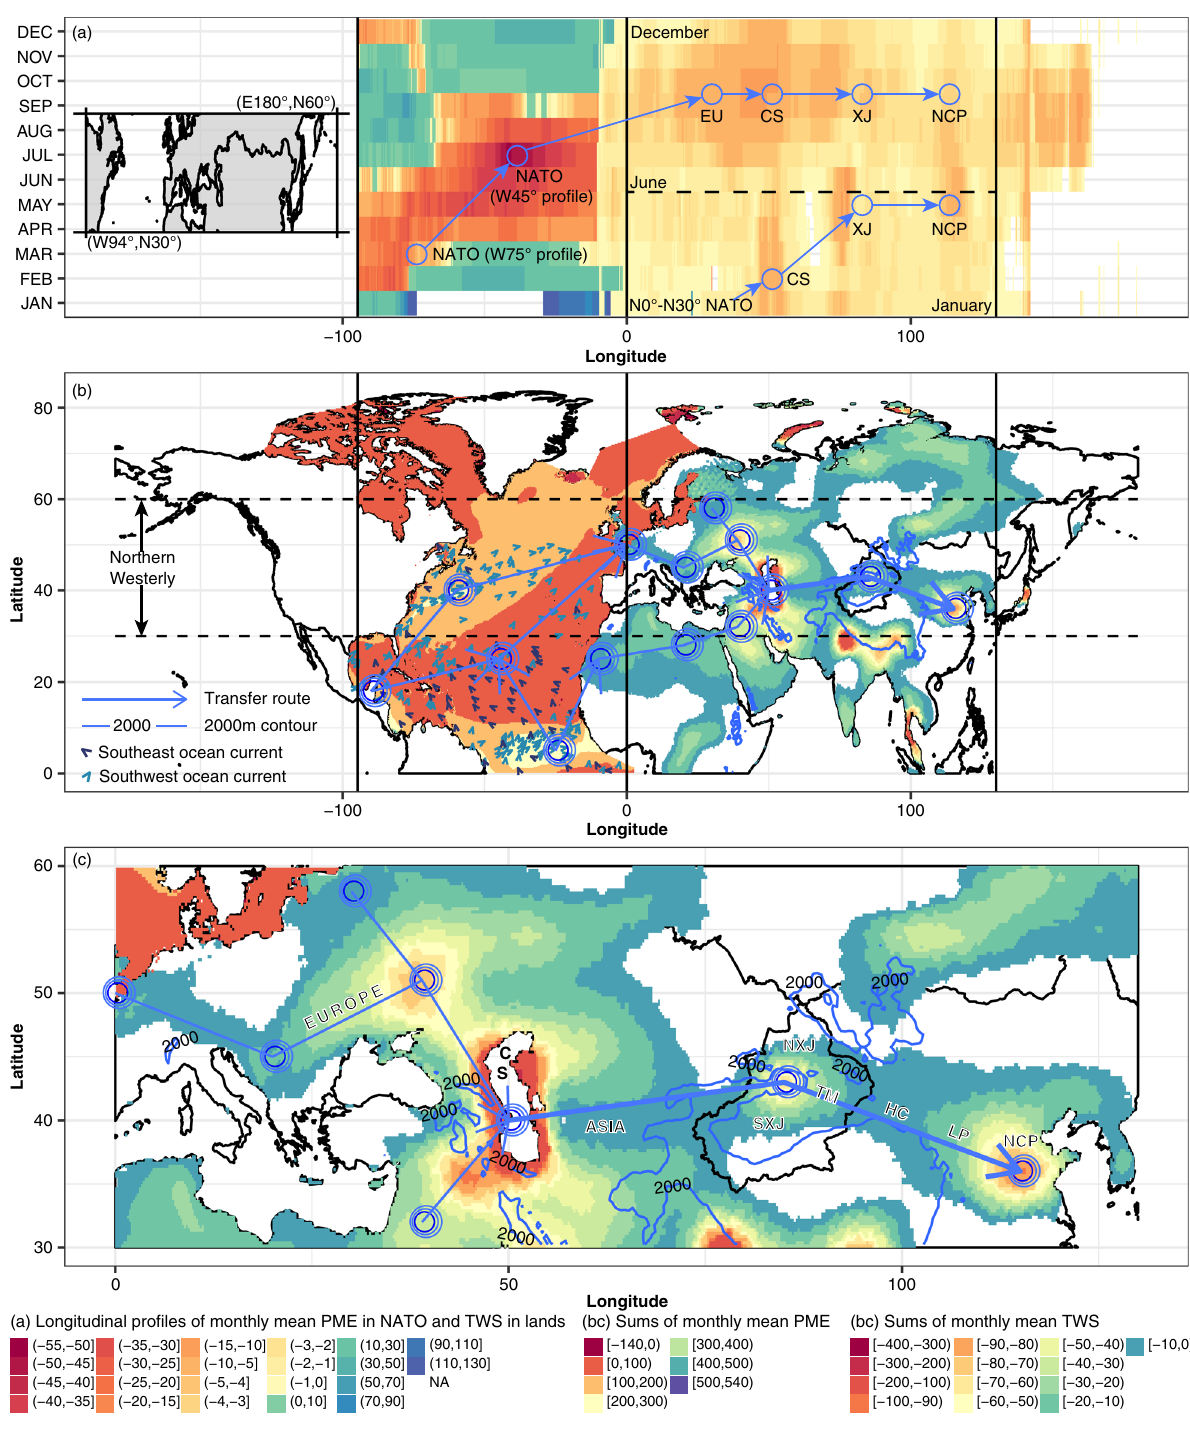
Fig. 3 Seasonal landfalling paths of PME de fi cit from NATO. Longitudinal pro fi le of monthly averaged mean precipitation-minus-evapotranspiration (PME) anomalies in the mid-latitude (N30° – N60°) Atlantic Ocean (NATO) and the monthly mean terrestrial water storage (TWSs) anomalies in mid- latitude (N30° – N60°) North Africa (NAF) and Eurasia from January to December ( a ). Spatial patterns of the sum of monthly mean PME anomalies (unit: mm) in NATO and the sum of negative monthly mean TWS anomalies (unit: mm) in lands during 2003 – 2017 ( b ). Transfer routes of the landfalling impacts of de fi cits in PMEs over northern NATO from ocean to land during 2003 – 2017 ( c ). The NXJ, SXJ, TM, HC, LP and NCP in subplot c refer to North Xinjiang, South Xinjiang, Tian Mountain, Hexi Corridor, Loess Plateau and North Chain Plain,